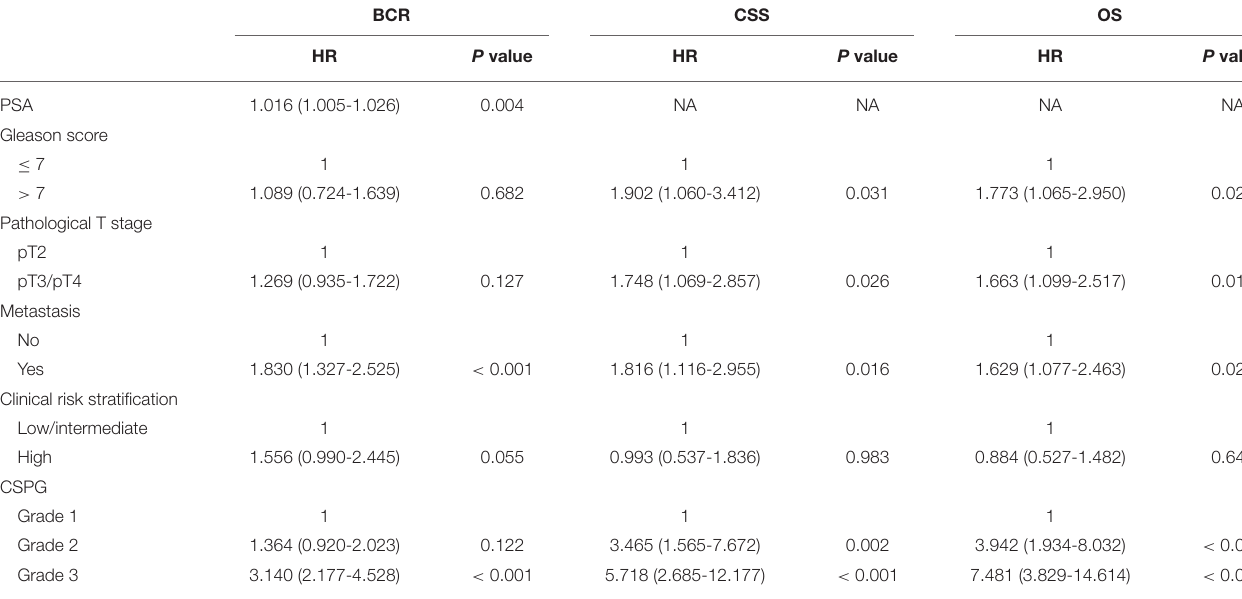
TABLE 4 | Results of multivariate Cox